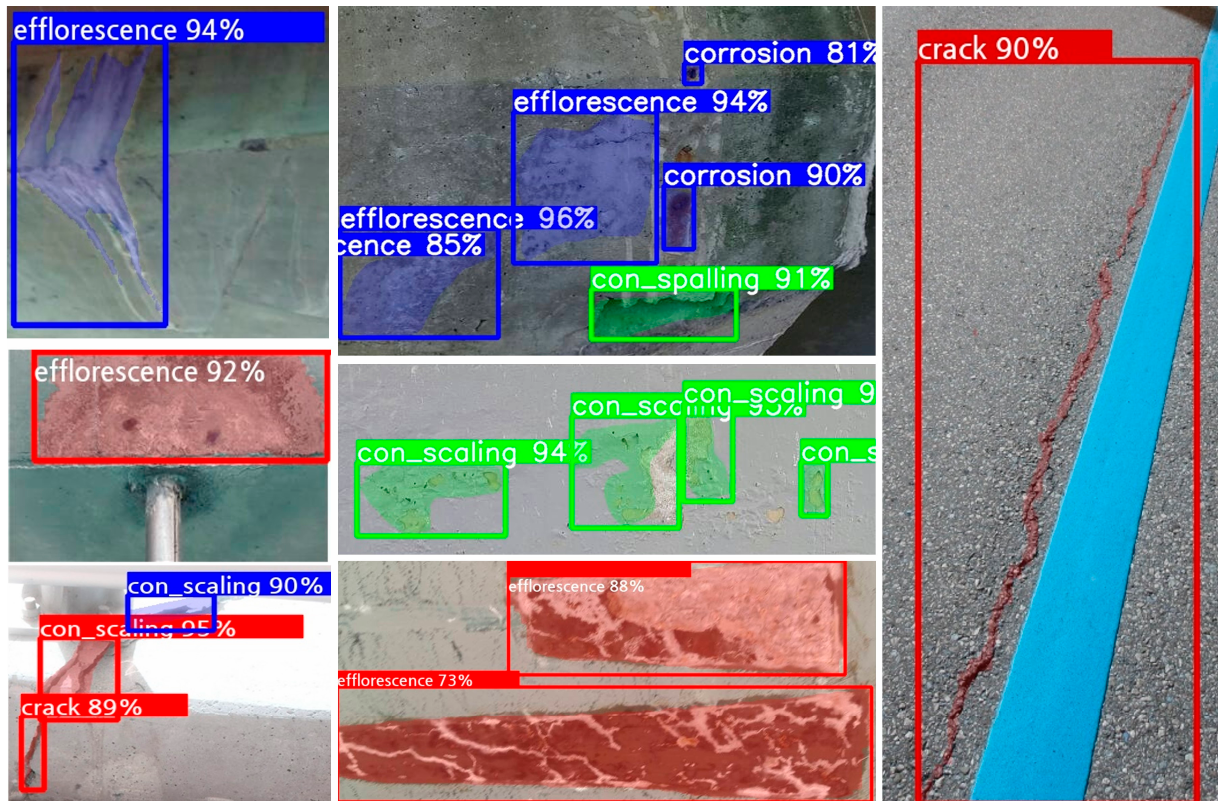
Figure 11. Result image of bridge damaged-object type and detection. Table 7. Damaged-object-detection performance results for existing models (all members integrated).